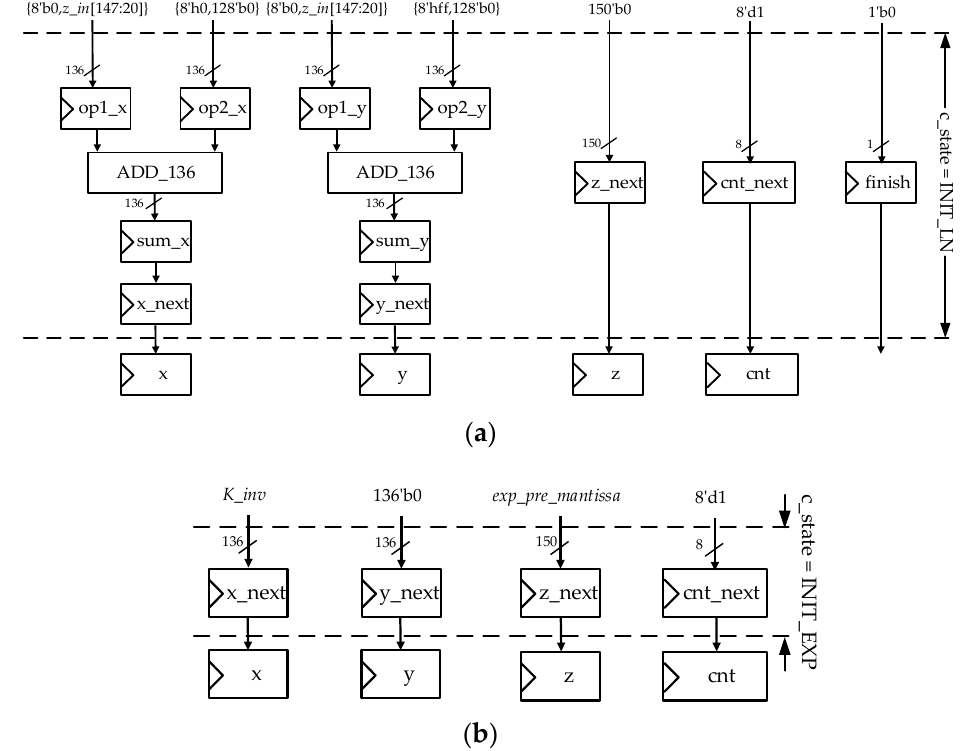
Figure 5. ( a ) Architecture of the state INIT_LN; ( b ) architecture of the state INIT_EXP.